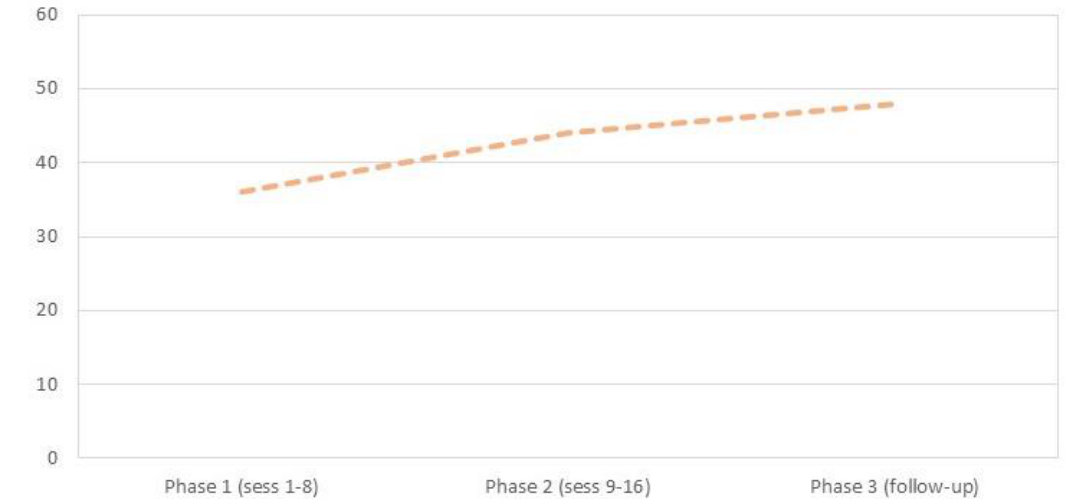
Figure 2: Level of mental functioning across the three phases of the therapy